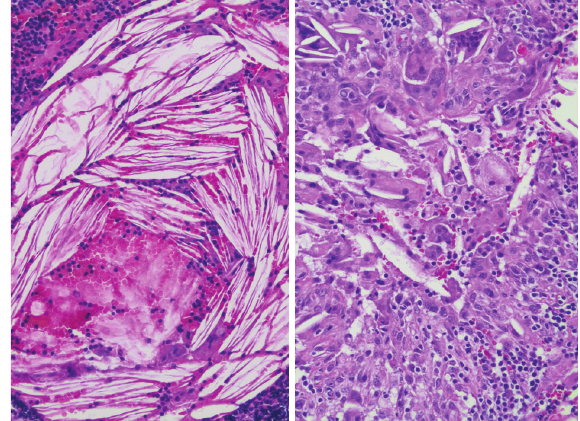
Figure2:H&Estainedsectionoftheappendix.H&Estainedsection oftheappendixonhighpowerviewofthenumerousxanthomacells, giant cells, and cholesterol